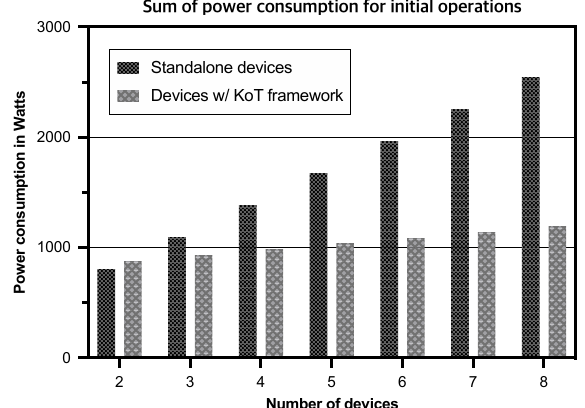
Figure 9. Comparison of the sum of power consumption for initial